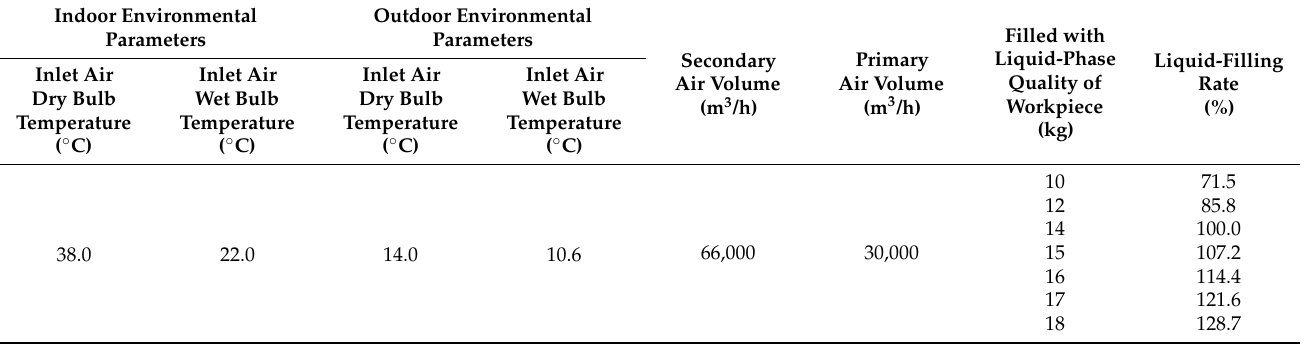
Table 8. Experimental working parameters of optimal liquid-filling